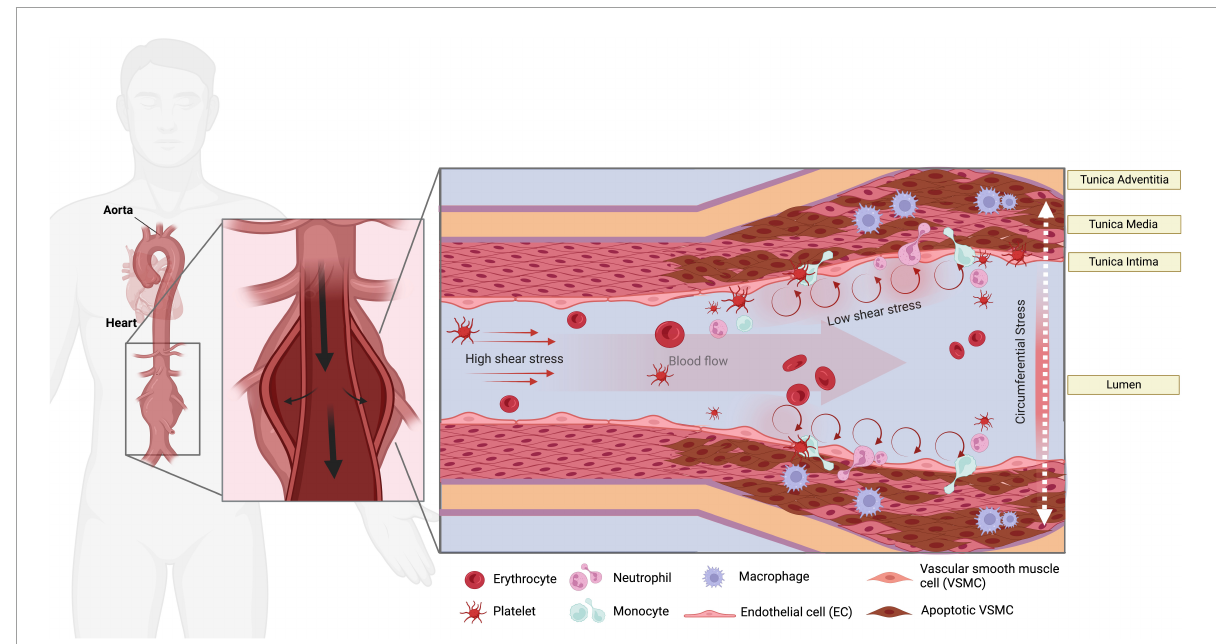
FIGURE1 Mechanical stressors in AAA. The endothelial layer of the aorta is subjected to high shear stress (HSS) in linear segments of the aorta. Turbulent low shear stress (LSS), along with the increase of circumferential stress imposed by blood pressure and aortic stiffness, are sensed at curved areas. LSS can over-activate the ECs to attract immune cells and contribute to the pathological remodeling and SMCs apoptosis via mechanosensory machinery in the ECs. Platelet activation and accumulation in the AAA sac likely occur during the progression of